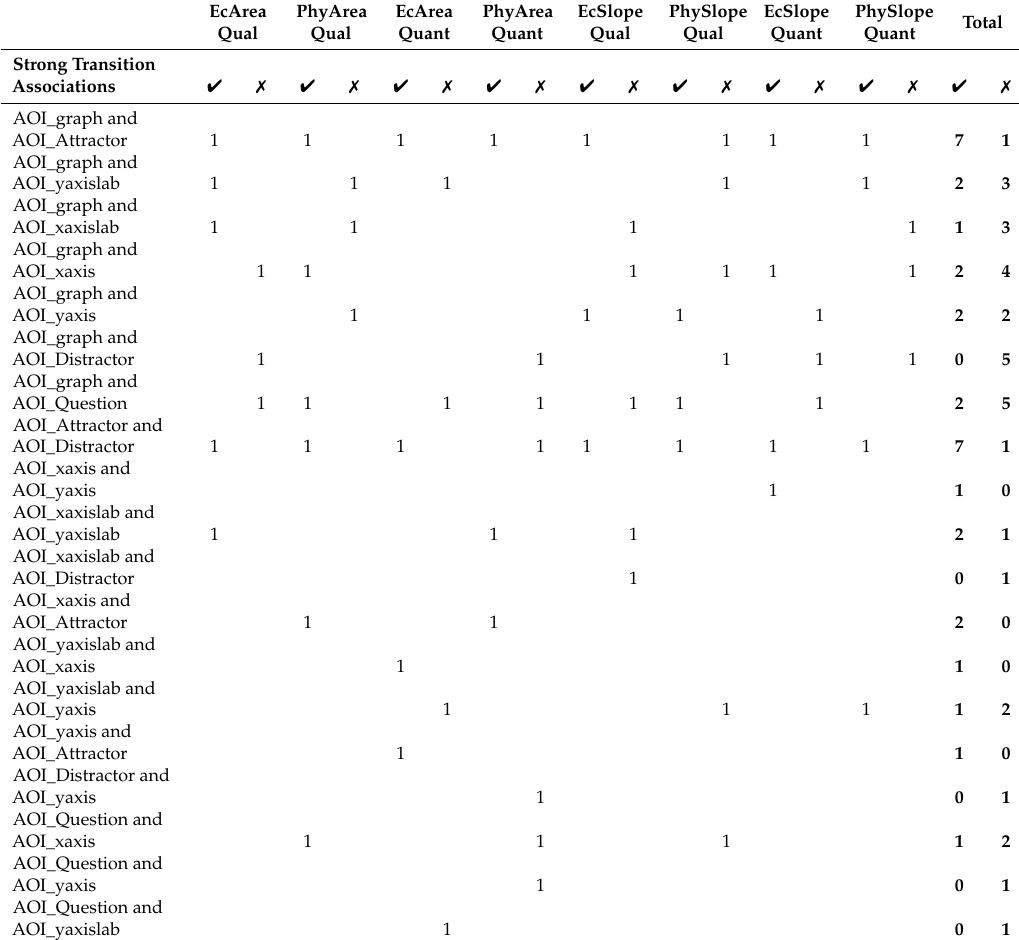
Table 6. Strong associations between gaze transitions across the tasks and correct vs. incorrect solvers. (Sum of strong associations across tasks in bold).